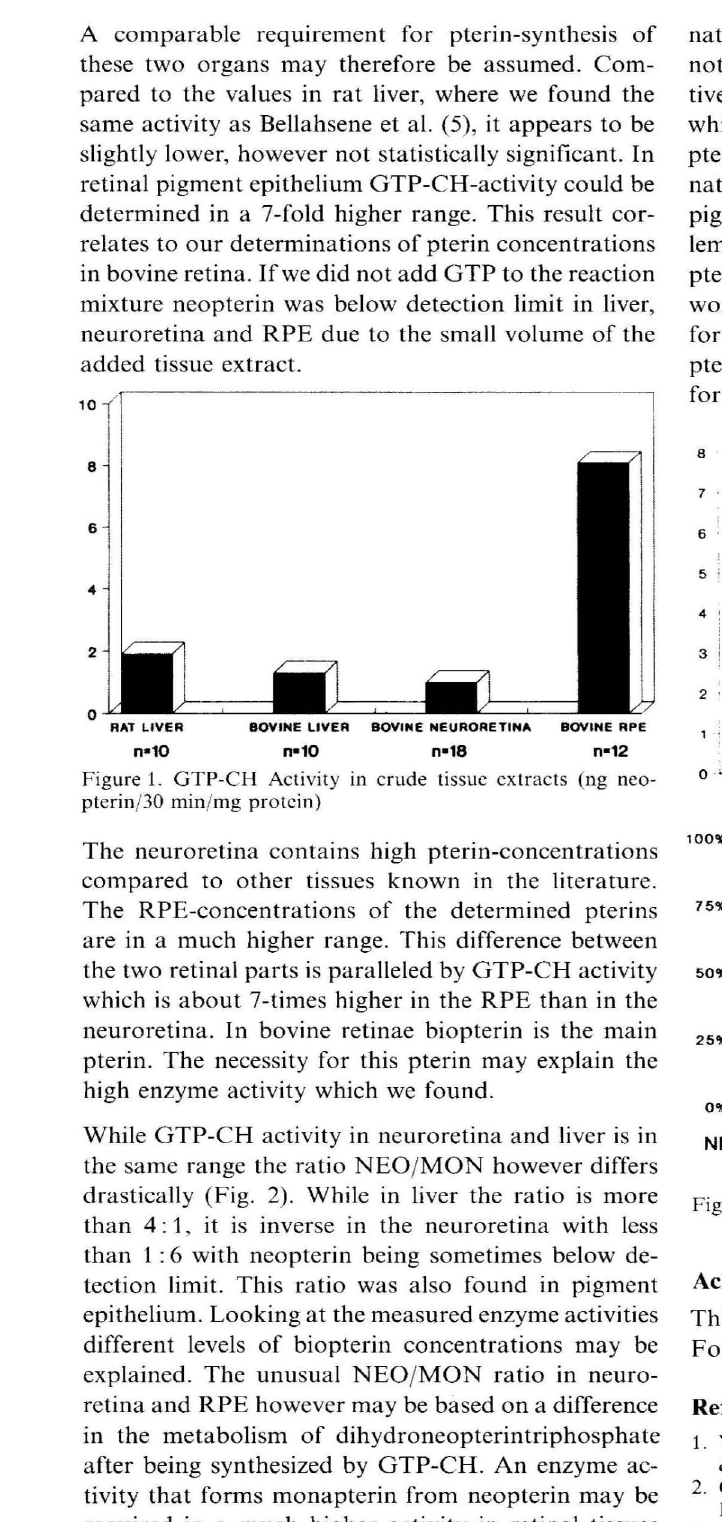
Figure 2. a) Relative GTP-CH activity b) Pterin pattern in bovine